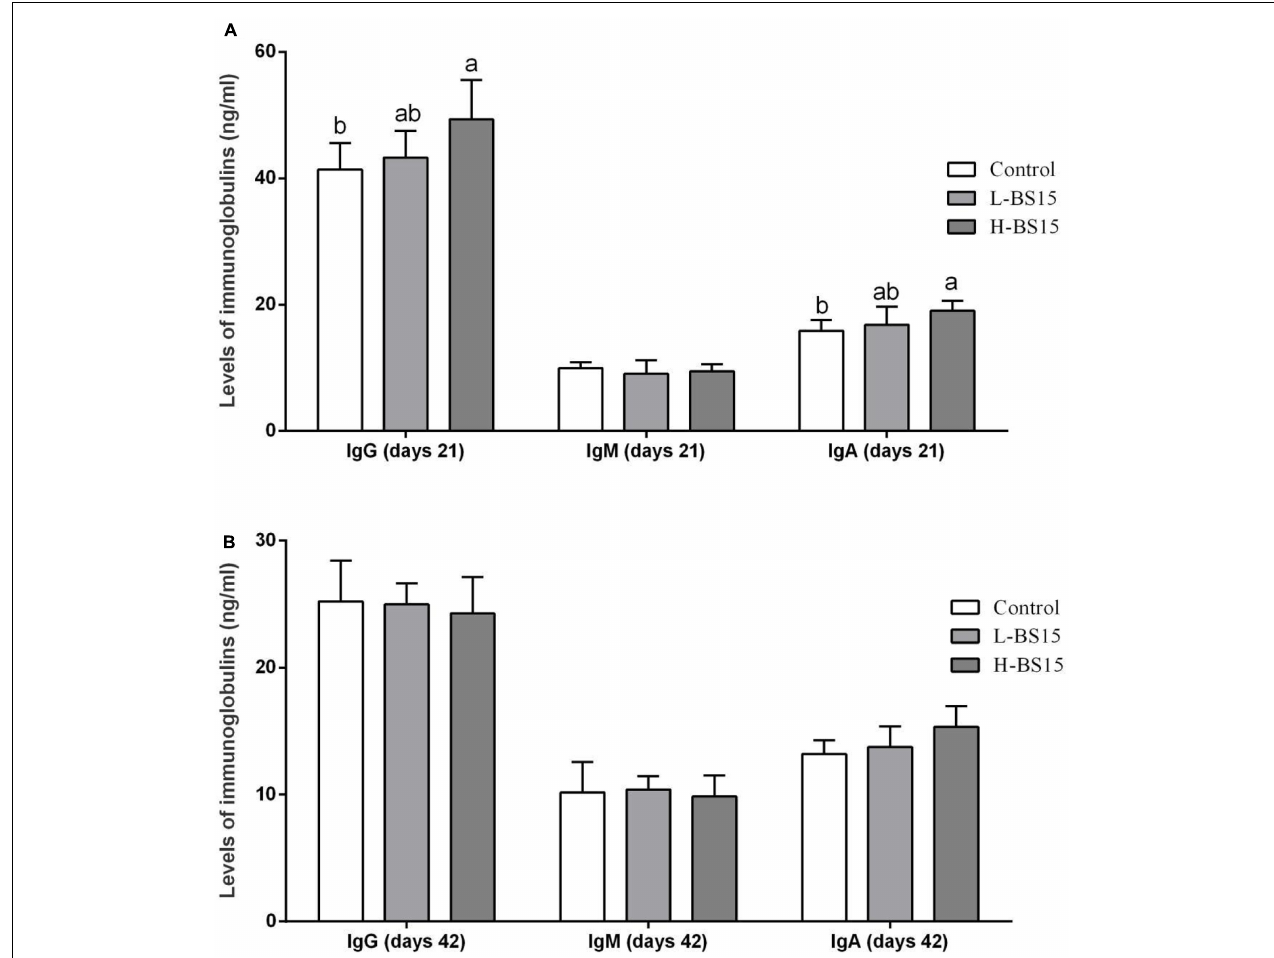
FIGURE 4 | Levels of immunoglobulins in the serum (Experiment 1). Bars with different letters are significantly different on the basis of Duncan’s multiple range tests ( P < 0.05). Data are presented as mean ± standard deviation (six replicates of one chick per cage). (A) Changes of IgG, IgM, and IgA in the serum at days 21; (B) changes of IgG, IgM, and IgA in the serum at days 42.